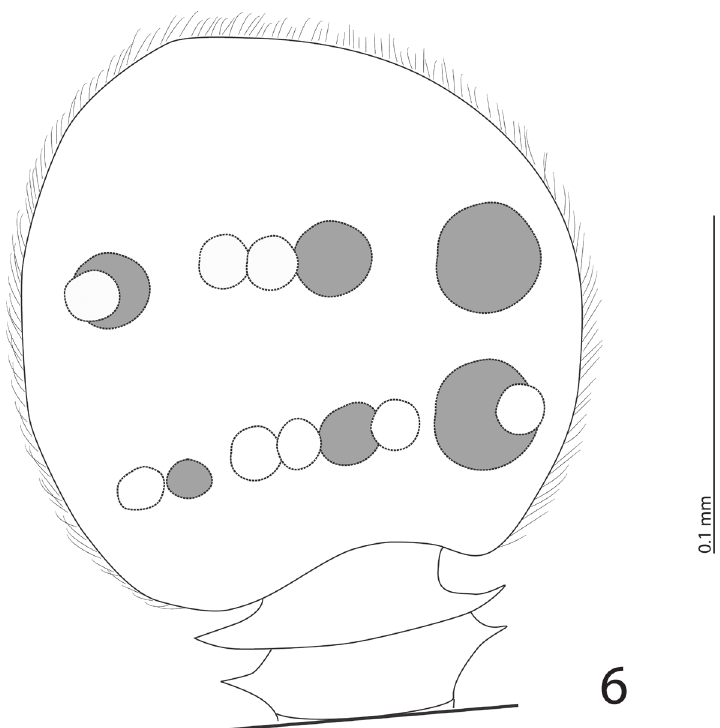
Figure 6. Eremosaprinus warneri sp. n., left antennal club, dorsal view (white circles show sensory areas and corresponding vesicles of dorsal side, grey circles depict sensory areas and vesicles of ventral